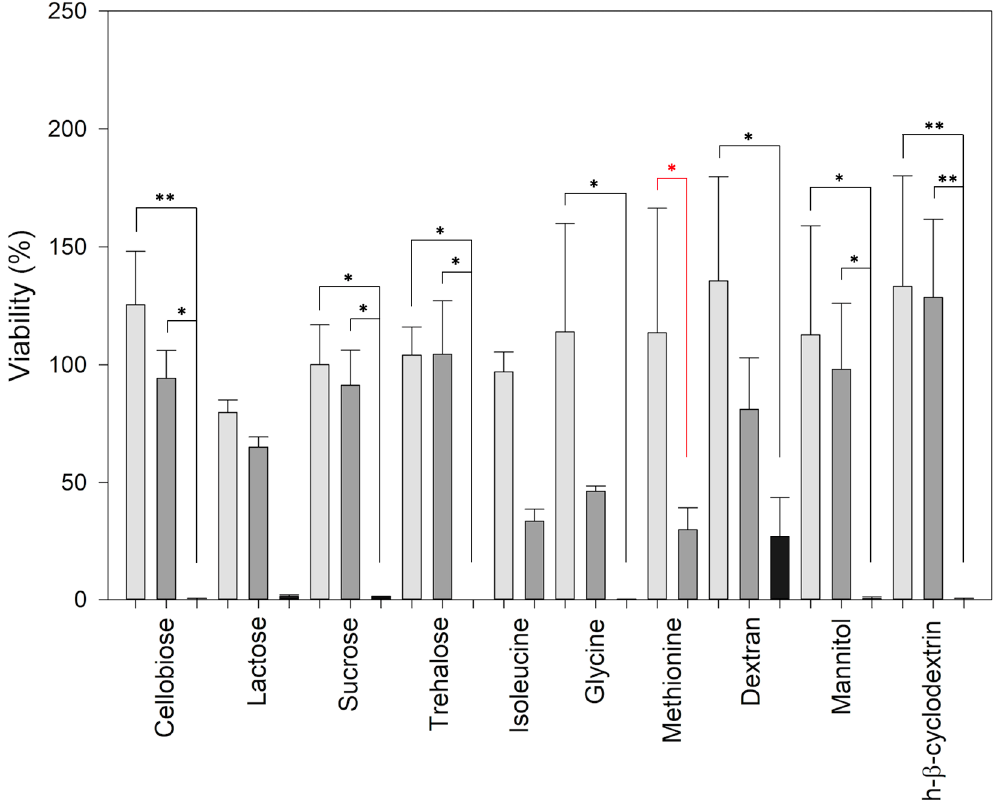
Figure 4. The graph represents the viability of lymphocytes after 48 h of treatment with the different excipients. Light grey is 1 mg/mL, dark grey is 10 mg/mL, and black is 100 mg/mL. Data are displayed as mean ± SE. ** for p ≤ 0.001 and * for p ≤ 0.05. Black asterisks represent the comparison of excipients at the three concentrations, without isoleucine and methionine, red asterisks, for all excipients at 10 and 1 mg/mL.